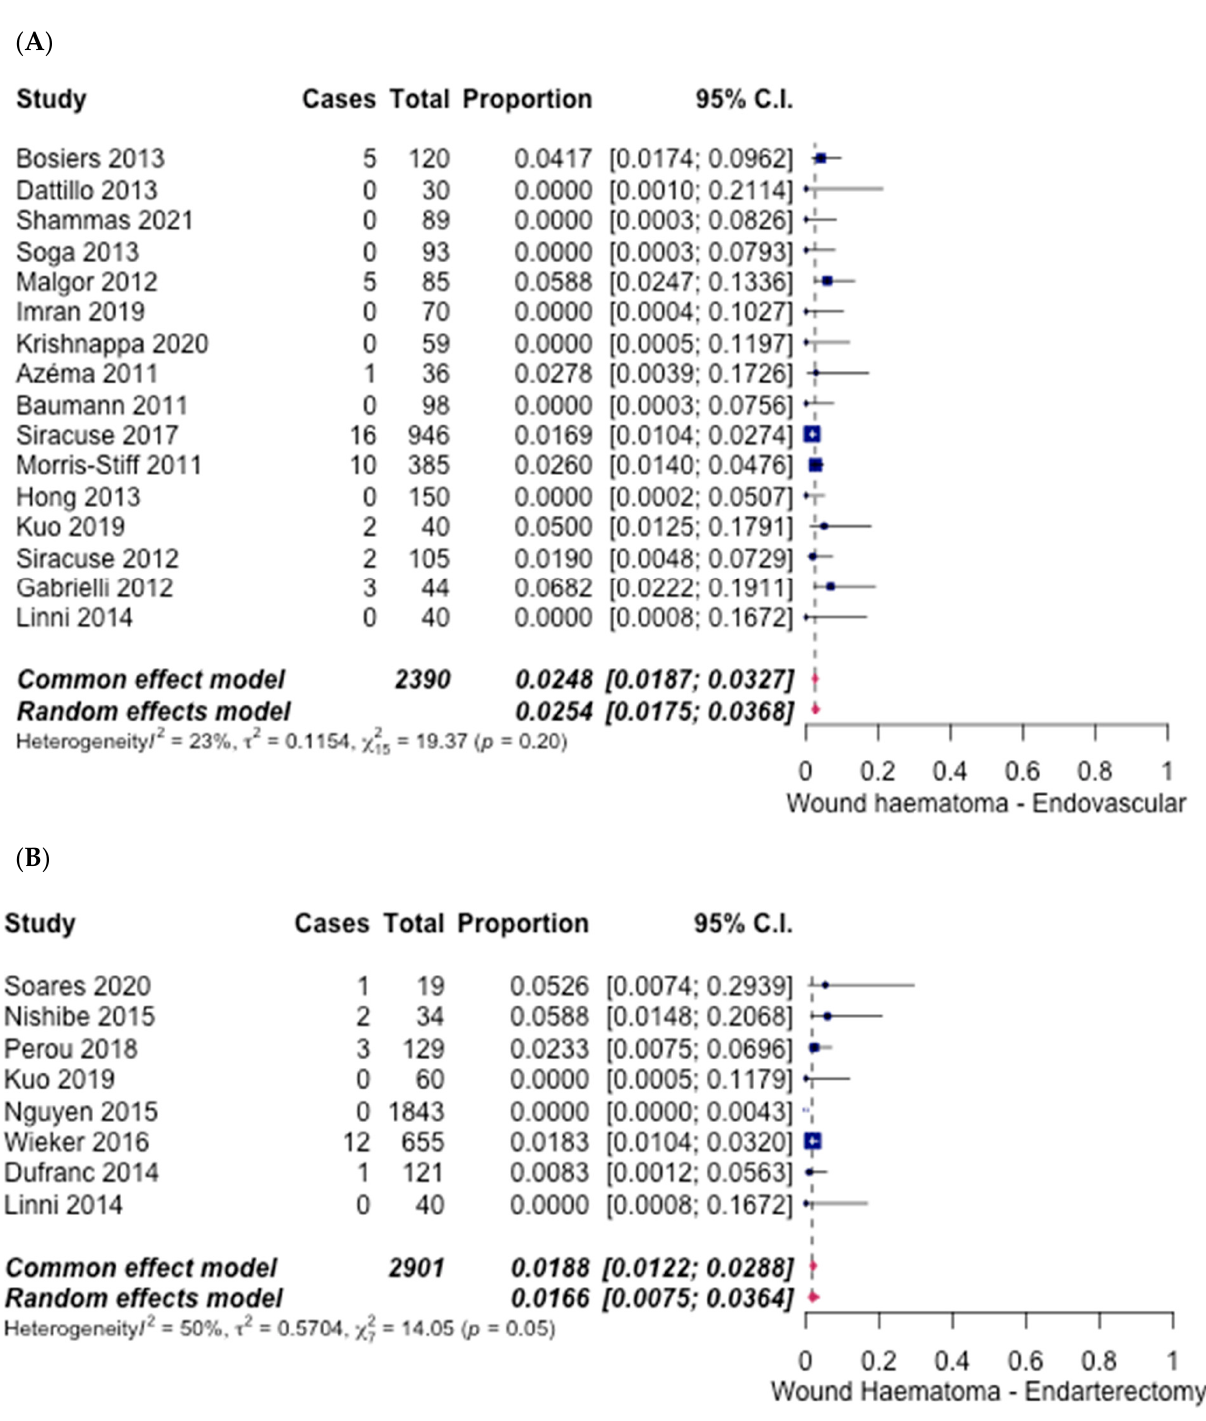
Figure 11. Forest plot for wound haematoma. ( A ) Endovascular intervention [6–8,10,12–22,27]. ( B ) Endarterectomy [6,21,23–26,28,29]. Delayed wound healing and dehiscence occurred in 1.07% (95% CI 0.56%, 2.05%]) (Figure 12A) of ET procedures (15 studies) [6,7,9,10,12–16,18,27], in contrast to 1.41% (95% CI [0.55%, 3.59%]) (Figure 12B) of FAE (seven studies) [6,13,21,23,24,29,30]. An odds ratio of 0.76 (95% CI [0.42–1.37], p = 1.36) was calculated, indicating no significant difference.